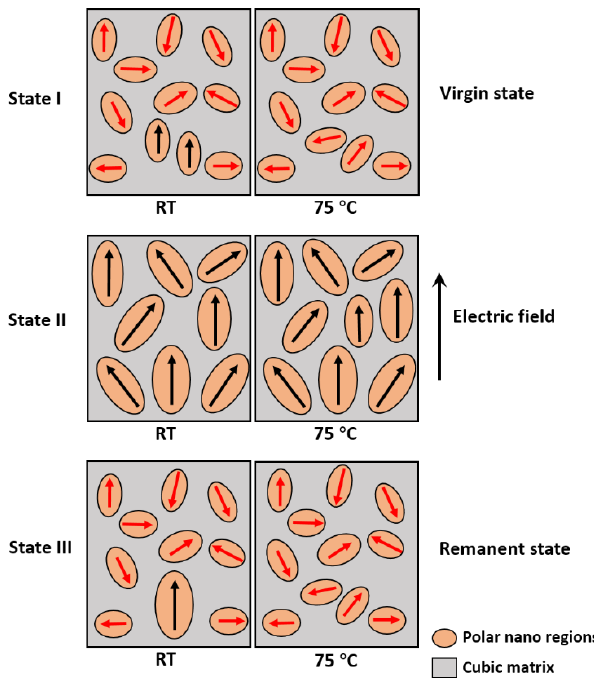
Figure 7. Schematic diagram illustrating the reorientation of PNRs under the influence of an applied electric field in the 0.7BF–0.3BT–2Nb ceramic, with both ergodic (reversible) and non-ergodic (partially irreversible) relaxor ferroelectric characteristics.